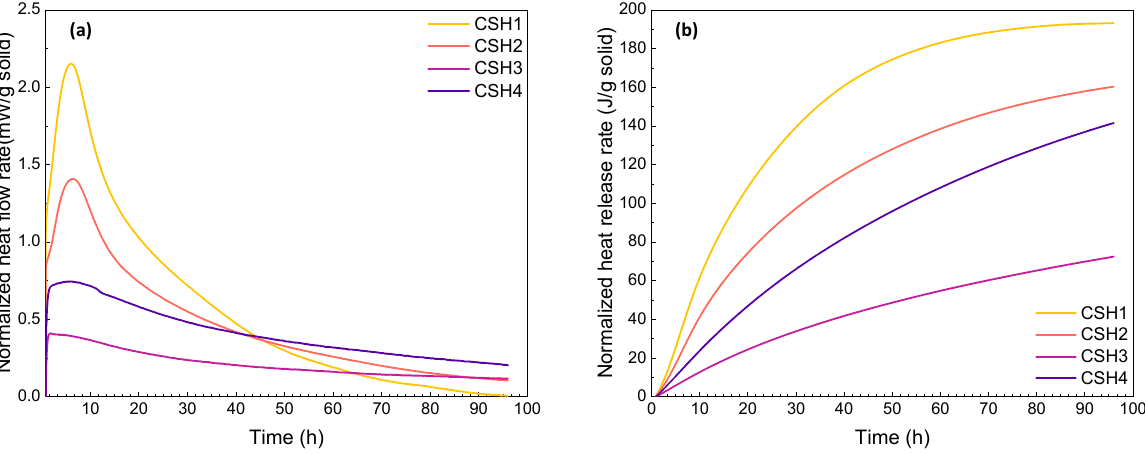
Figure 1. ( a ) Heat flow and ( b ) heat release rates of CSH gels measured by isothermal calorimetry at 23 °C over a reaction time of 0–96 h.